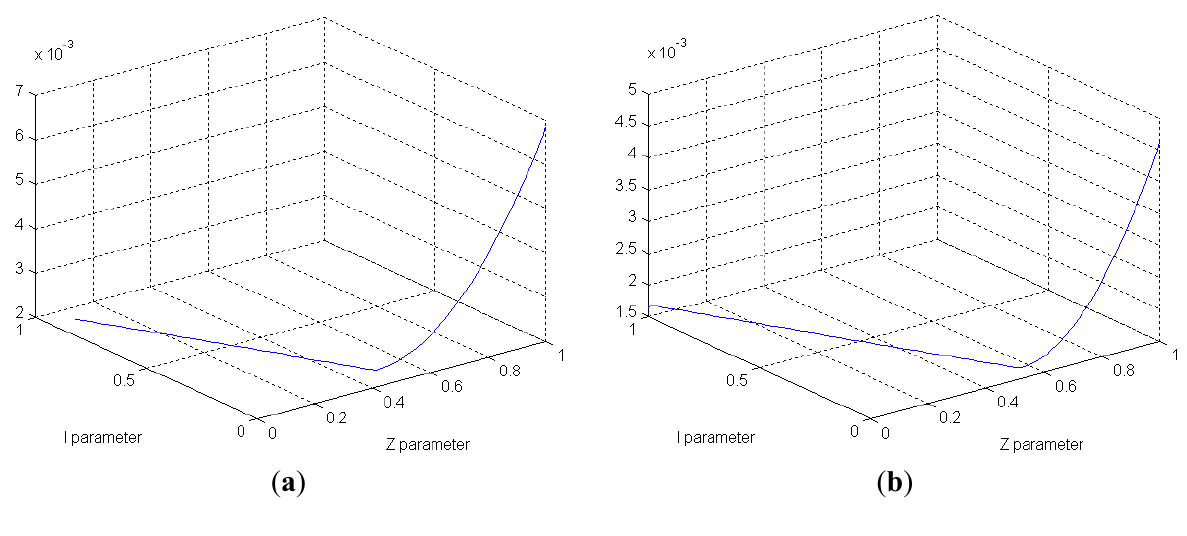
, ( b ) minimum reactive objective Z . Z